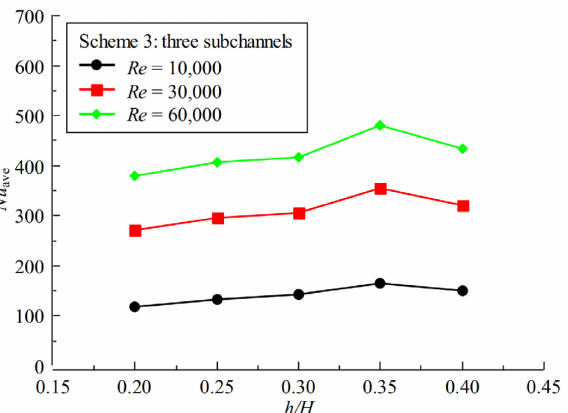
Figure 11. Effects of h/H on heat transfer performance of X-shaped truss array channels of Scheme 3 at different Reynolds numbers.